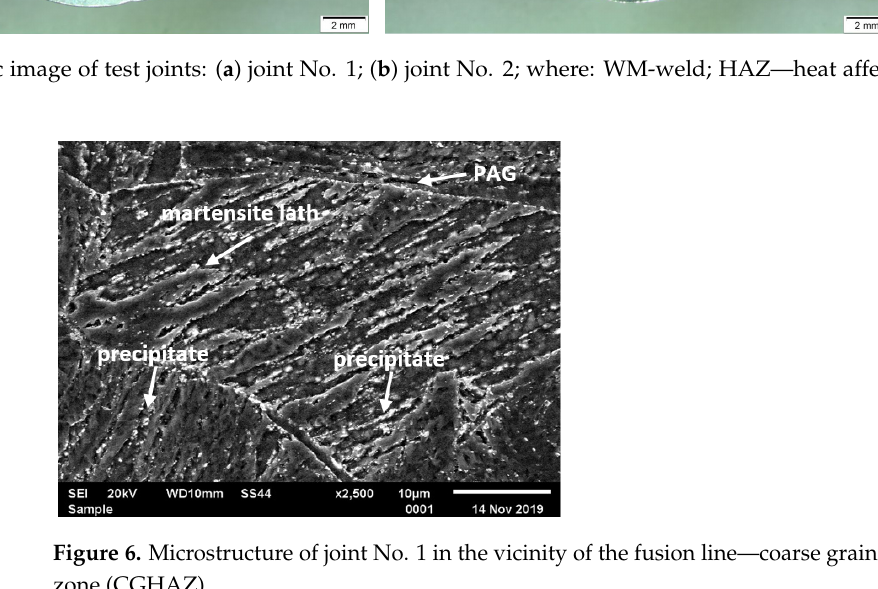
Figure 6. Microstructure of joint No. 1 in the vicinity of the fusion line—coarse grained heat-af- fected zone (CGHAZ).